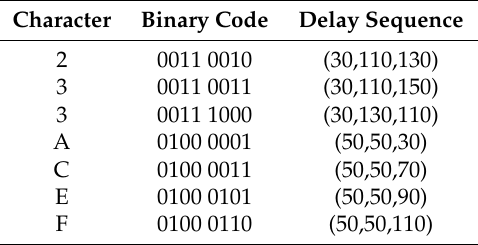
Table 2. Coding mapping